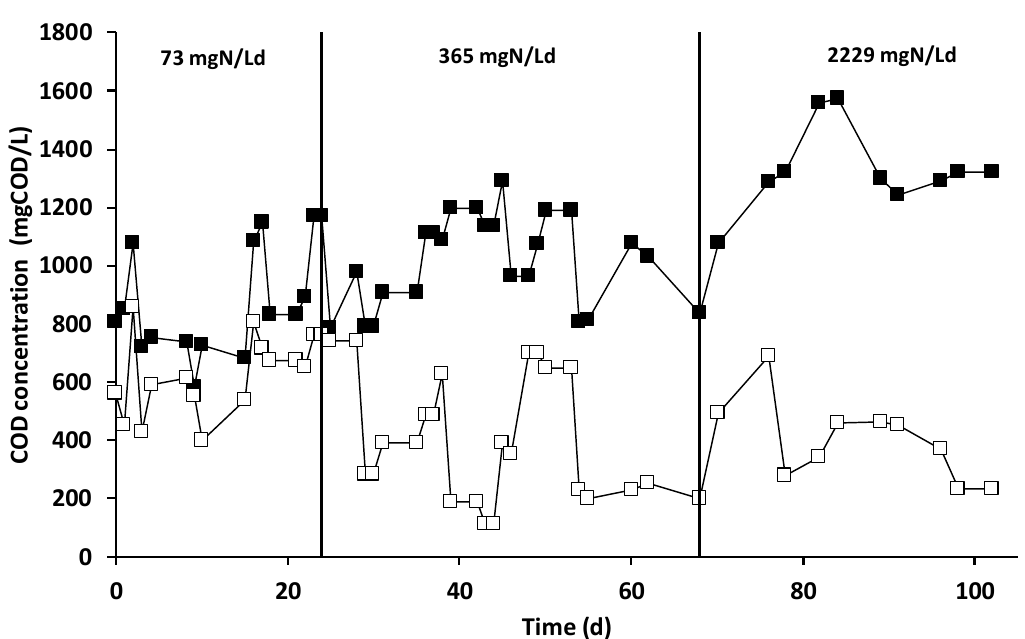
Figure 3. Influent and effluent COD concentration in the anodic chamber of the MEC during the three operational periods.